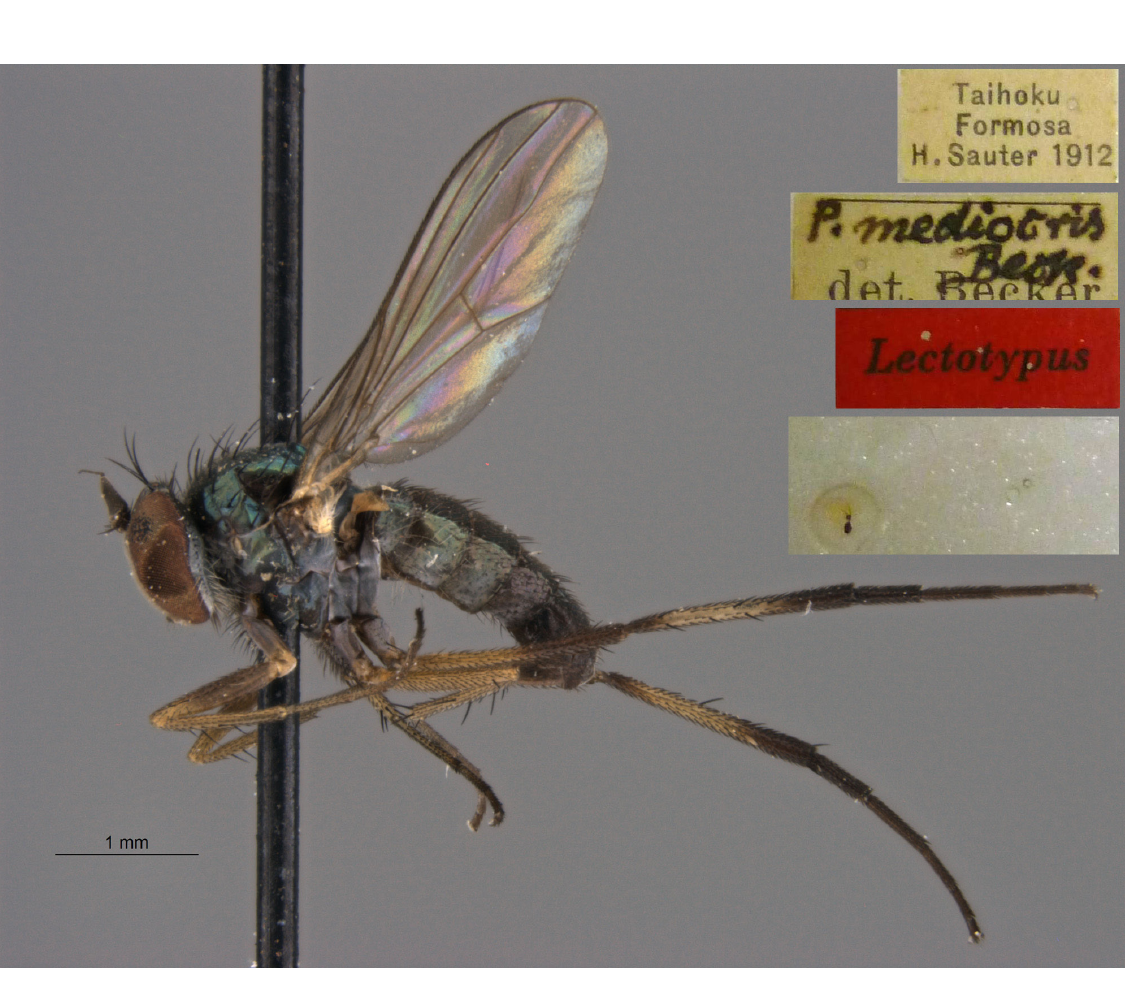
Fig. 9. Rhaphium mediocre (Becker, 1922), lectotype, ♂, habitus, with labels and preparation of male terminalia on plastic sheet (MfN). (Photo credit Mr Bernhard Schurian and Sven